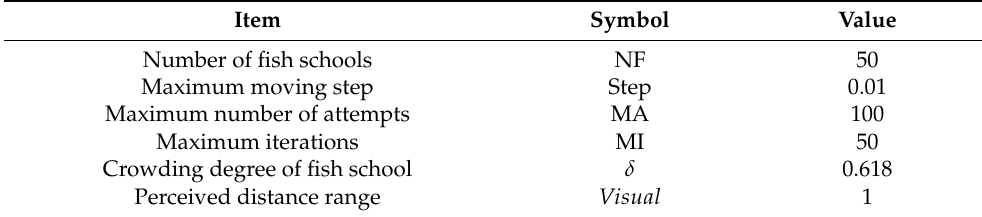
Table 1. Parameters of the artificial fish school algorithm.